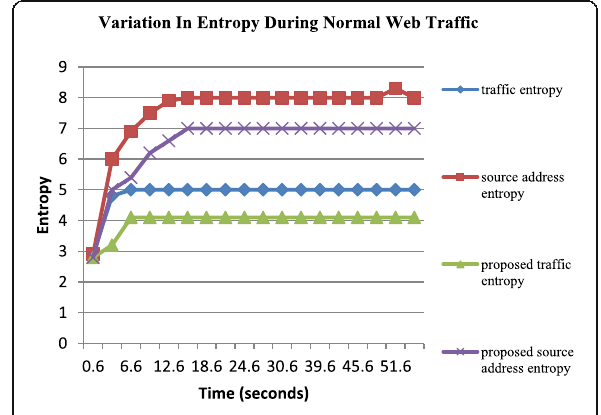
Fig. 6 Variation in entropy during normal web traffic. Variation is found between source address entropy and traffic